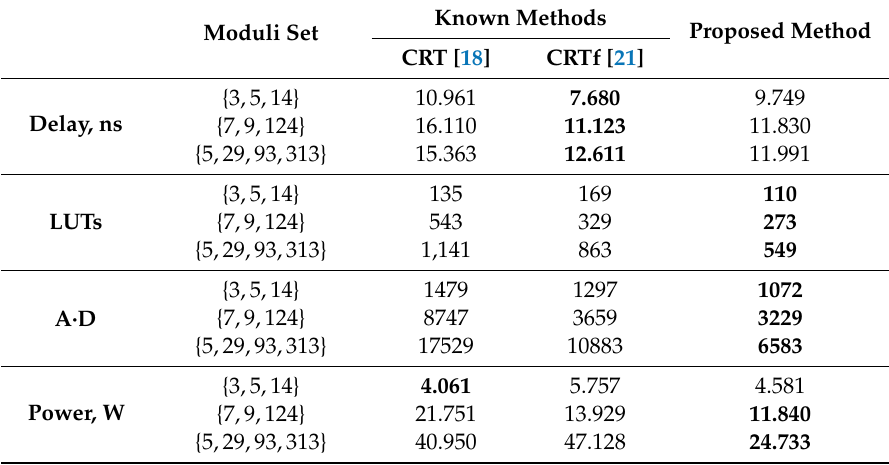
Table 2. Modeling results of the circuit of magnitude comparison.